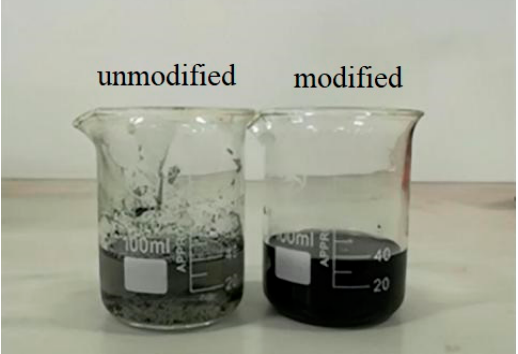
Figure 17. Dispersion image of nanographene in the distilled water before and after